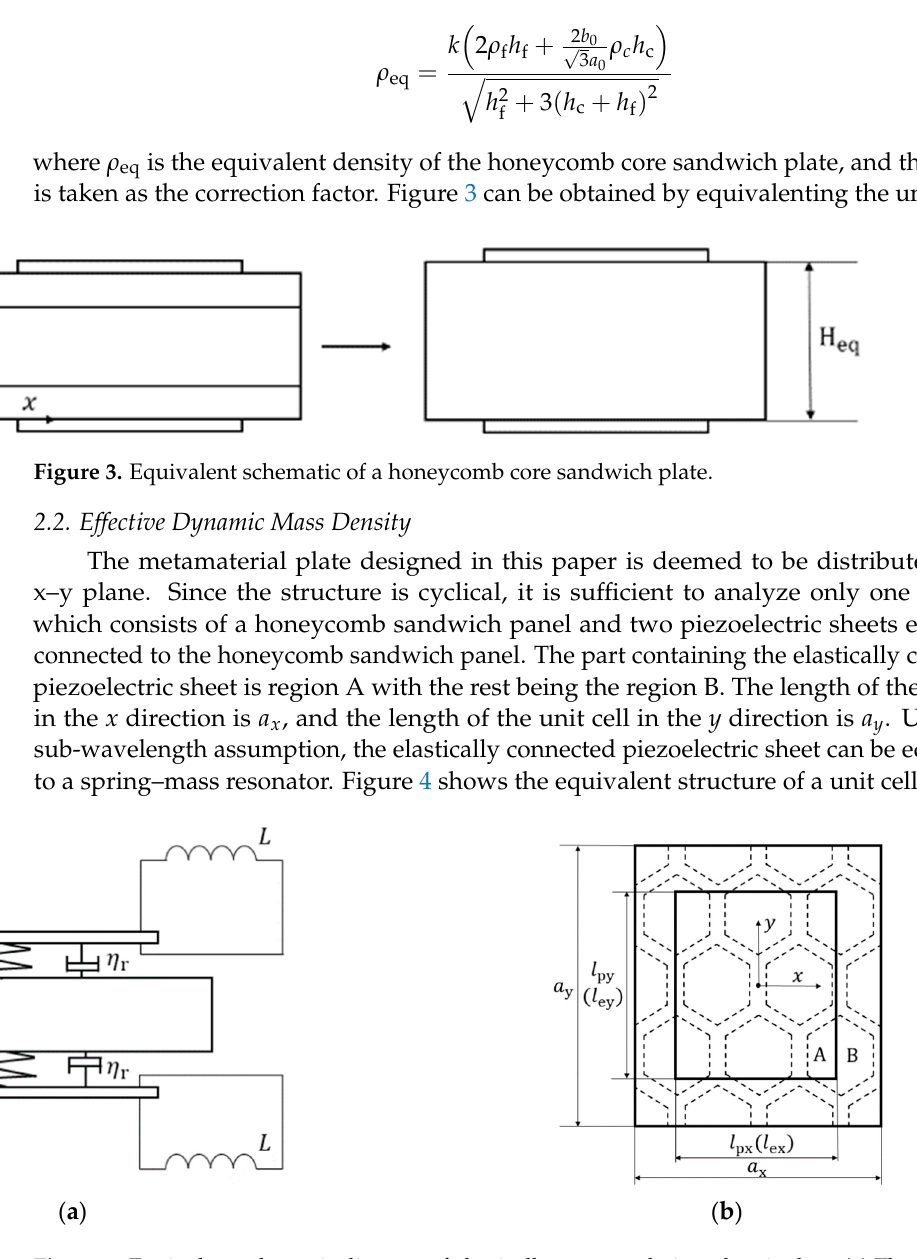
Figure 4. Equivalent schematic diagram of elastically connected piezoelectric sheet ( a ) The front view and ( b ) the top view.